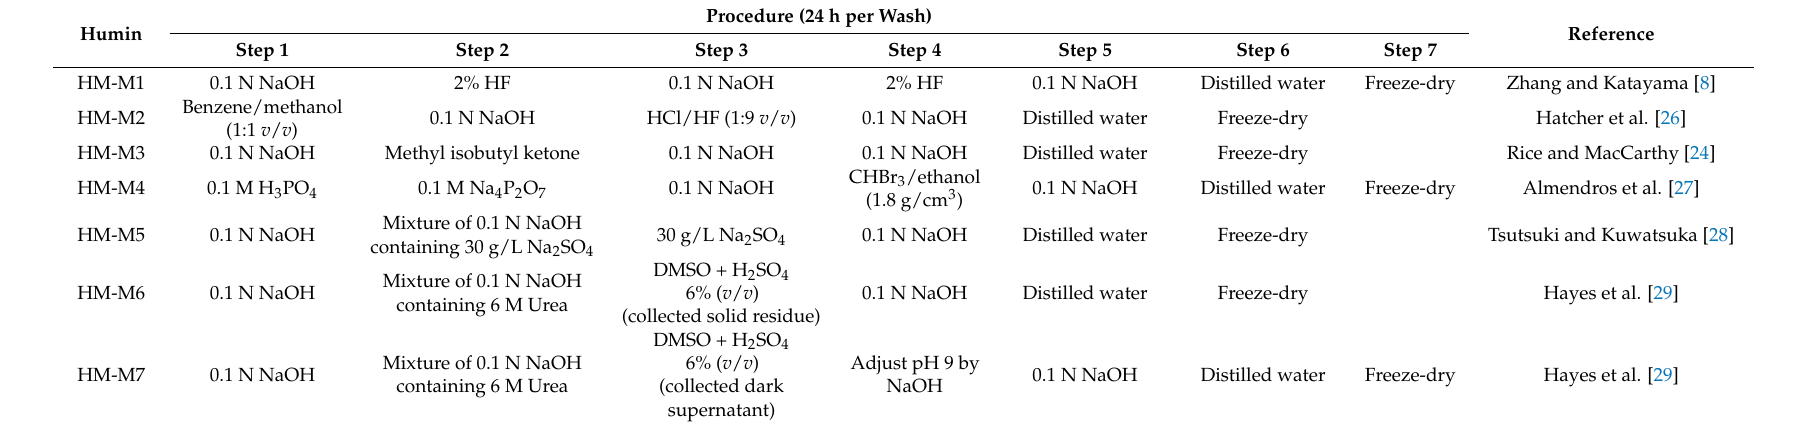
Table 1. Overview of isolation methods of the seven